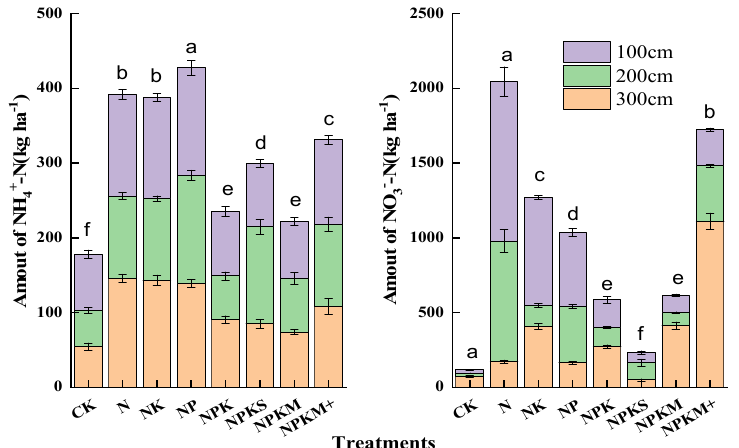
Figure 4. Accumulation of NO 3 − -N and NH 4+ -N in the 300 cm soil profile under different fertilization treatments in 2013 (Different letters showed significantly different from LSD at the 0.05).